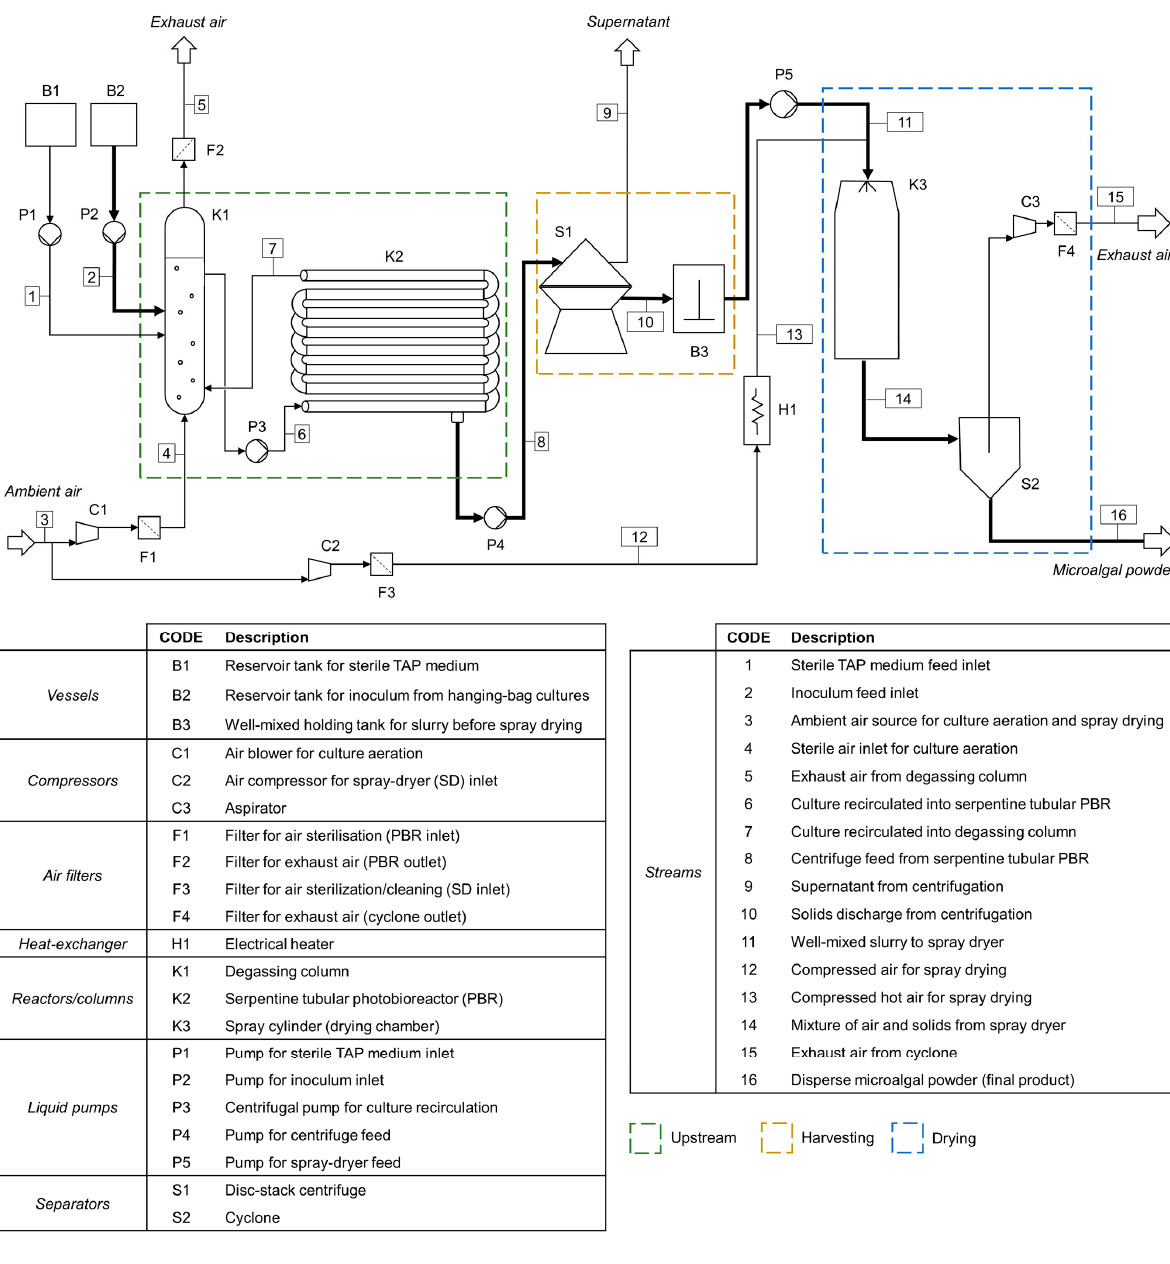
Figure A2. Process flow diagram of the production of a microalgae-based edible vaccine with a spray-drying strategy.